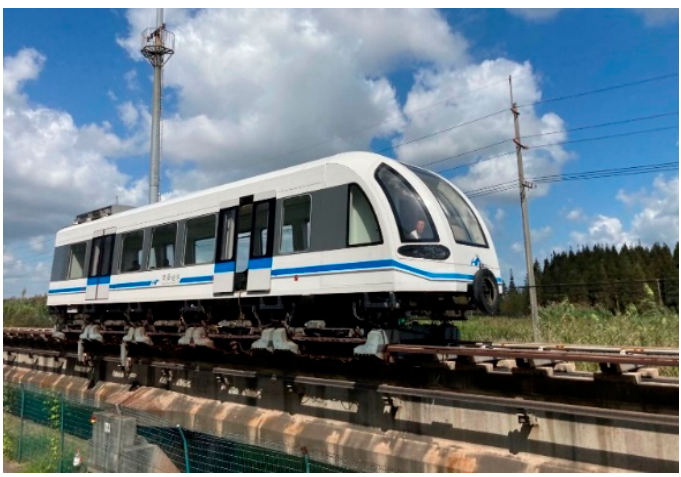
Figure 5. Coupled low-to-medium-speed maglev train and steel beam system in the field test.